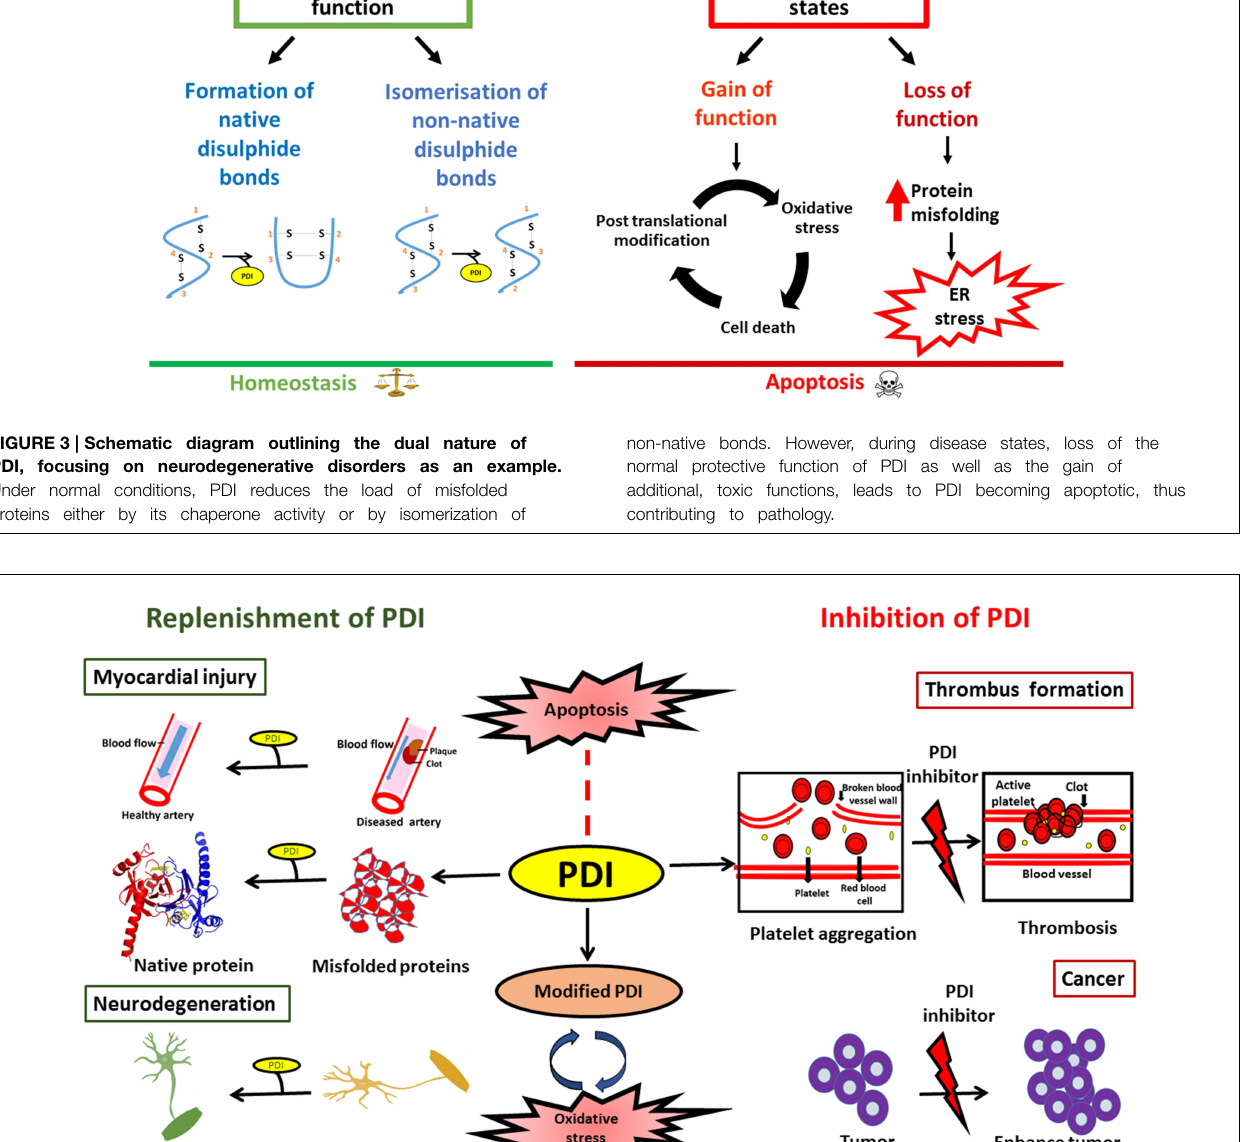
FIGURE 4 | Schematic diagram illustrating possible therapeutic applications to modulate PDI